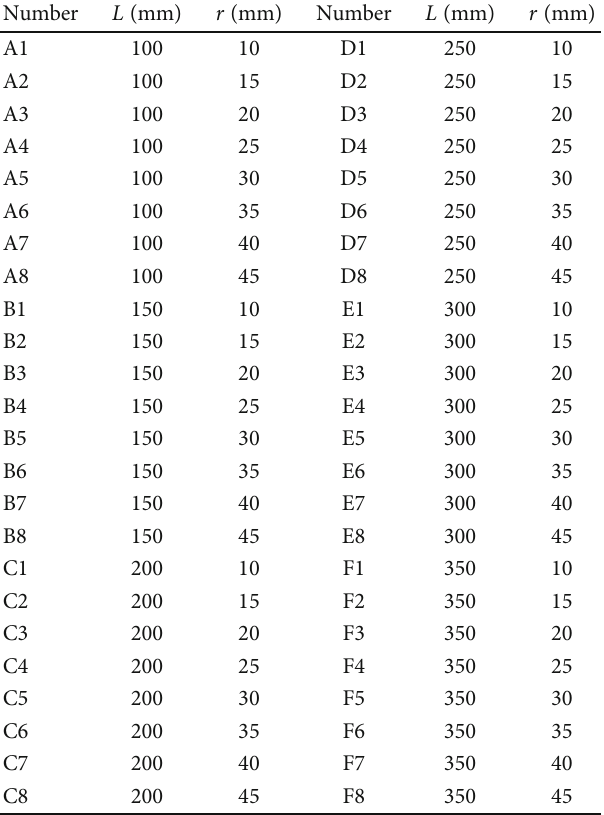
Table 2: Geometric dimensioning of